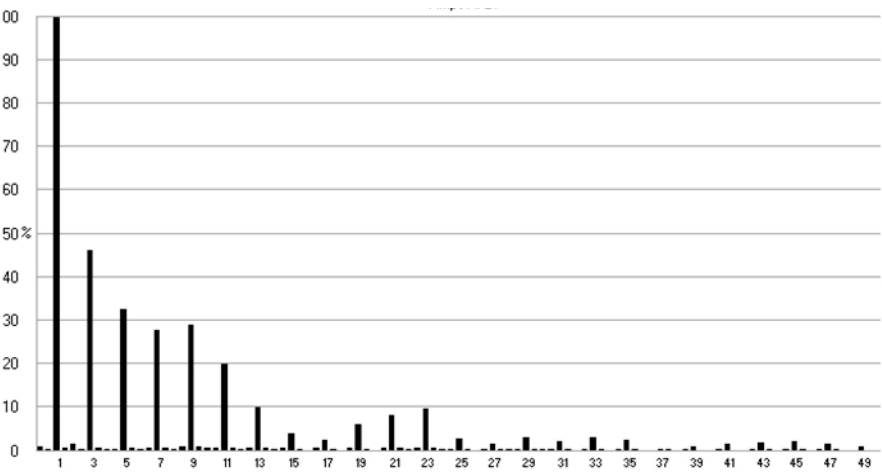
Figure 10. Set of office equipment: harmonic spectrum and current total harmonic distortion factor. THD I = 74.7%